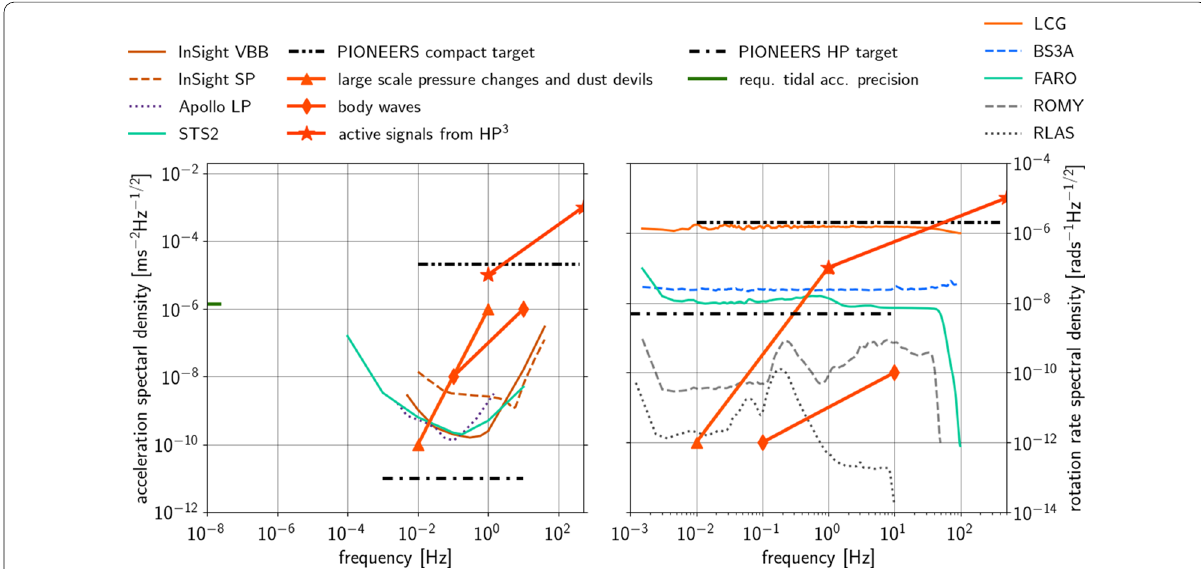
Fig. 9 Expected signal levels on Mars. For forced librations and tidal accelerations, the required resolution is shown. Additionally, self‑noise levels of commonly used sensors are shown (see Fig.